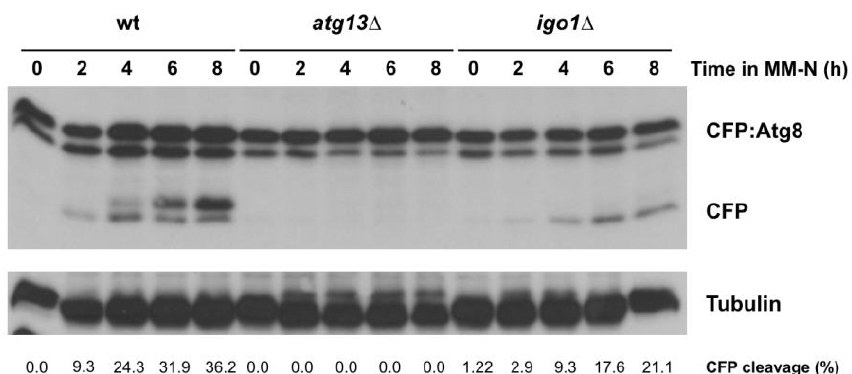
Figure 3. Endosulfine (Igo1) accelerates autophagic flux. Wild type, atg13 ∆ , and igo1 ∆ cells expressing CFP:Atg8 were grown in minimal medium at 25 ◦ C until mid-exponential phase and then transferred to nitrogen-free minimal medium (MM-N) for 8 h at 25 ◦ C. Samples were taken at 0, 2, 4, 6, and 8 h in MM-N. Levels of CFP:Atg8 and free CFP were determined using anti-GFP antibodies (Clontech). Tubulin was used as a loading control. The percentage of CFP cleavage is indicated under the gels.